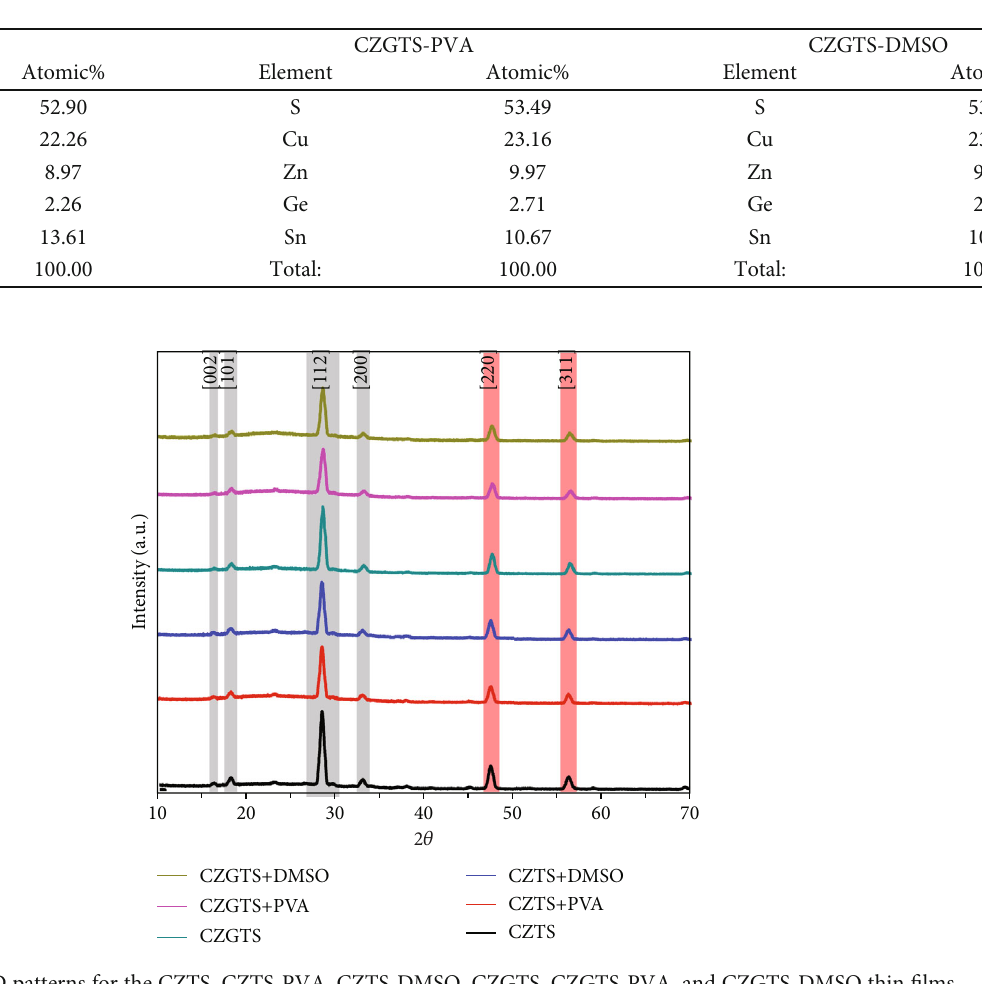
Figure 5: XRD patterns for the CZTS, CZTS-PVA, CZTS-DMSO, CZGTS, CZGTS-PVA, and CZGTS-DMSO thin fi lms.